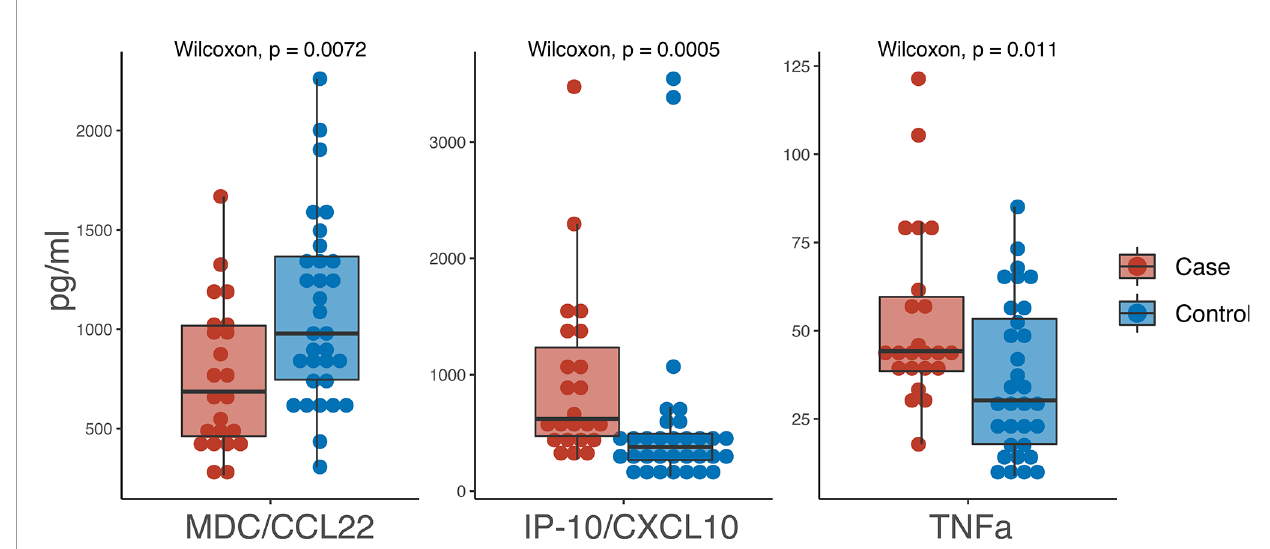
FIGURE 2 | Boxplot of pg/ml values from serum biomarkers. Red indicates cases and blue indicates controls.